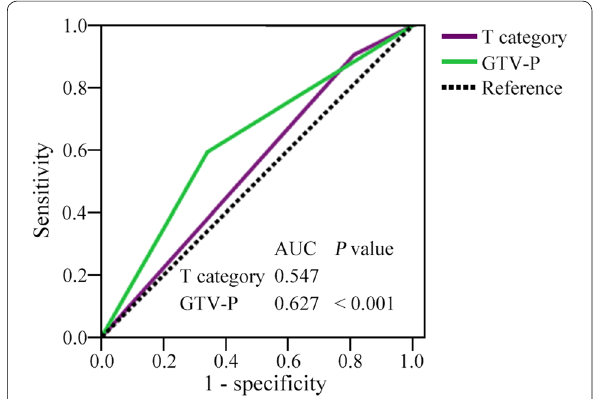
Fig. 4 Receiver operating characteristic (ROC) curves for OS predic‑ tion with T category and